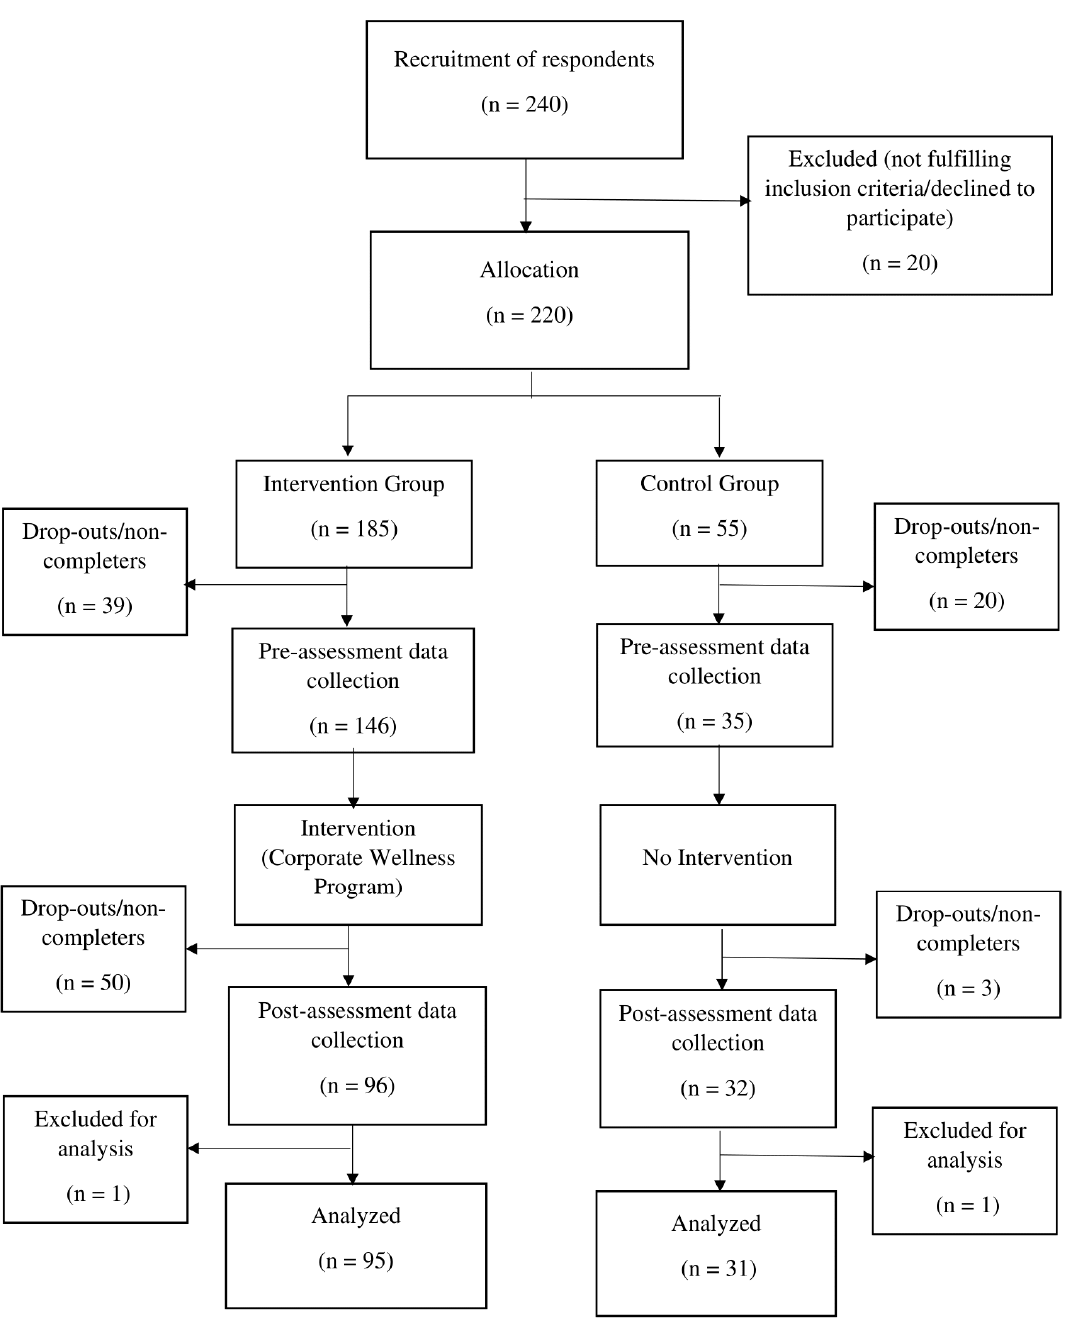
Figure 2. Participant recruitment process flow diagram.